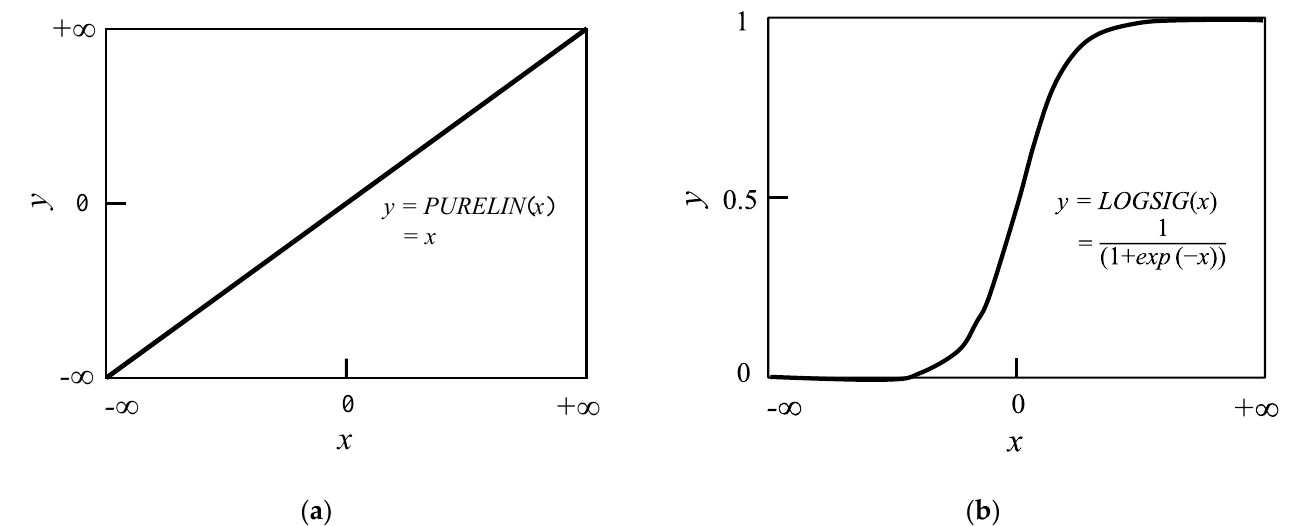
Figure 5. Activation functions of ANN model: ( a ) PURELIN; ( b ) and LOGSIG function.